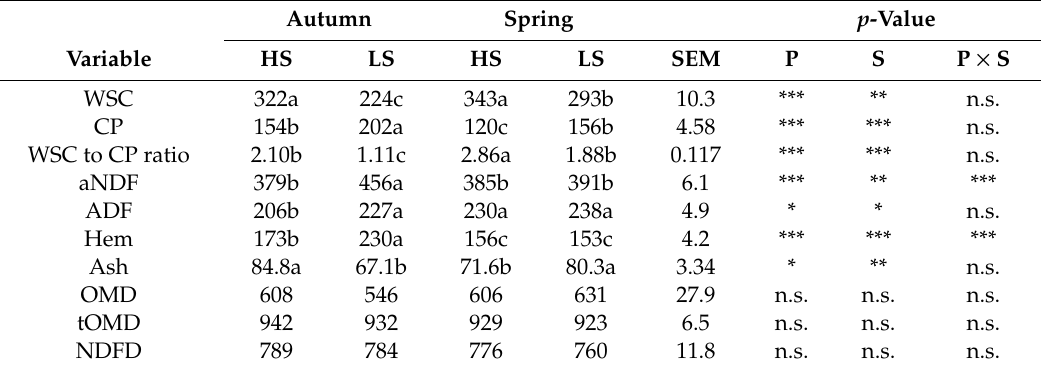
Table 1. Chemical composition and in vitro digestibility of pastures across regrowth periods. Autumn Spring p -Value Variable